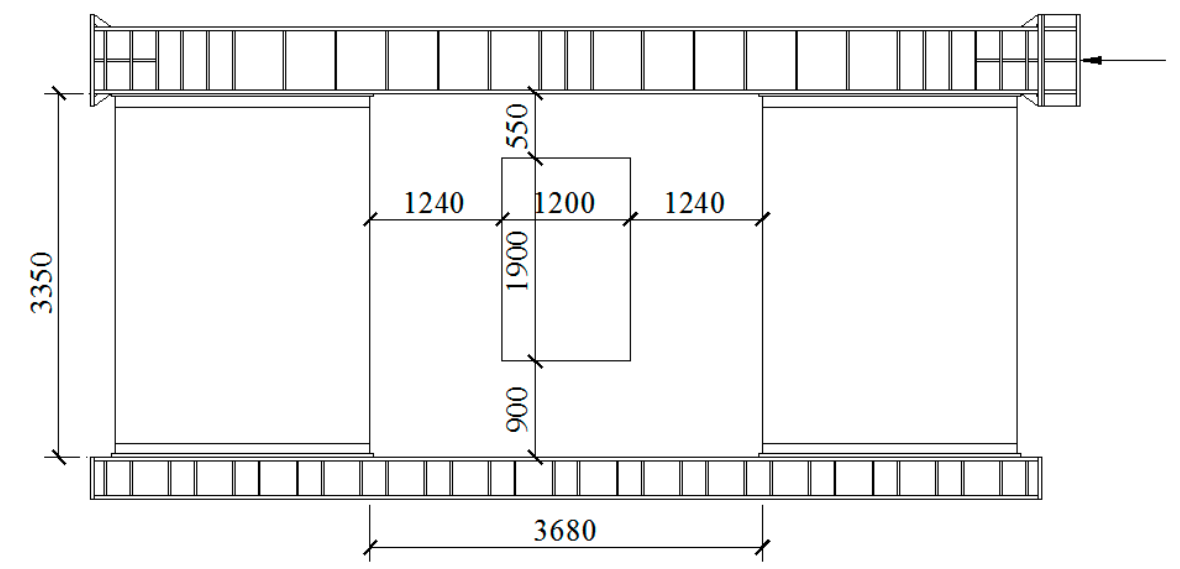
Figure 14. Location of the opening (units in mm).